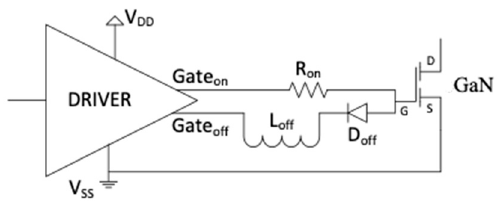
Figure 15. Drive circuit solution to provide negative voltage during the gap time.